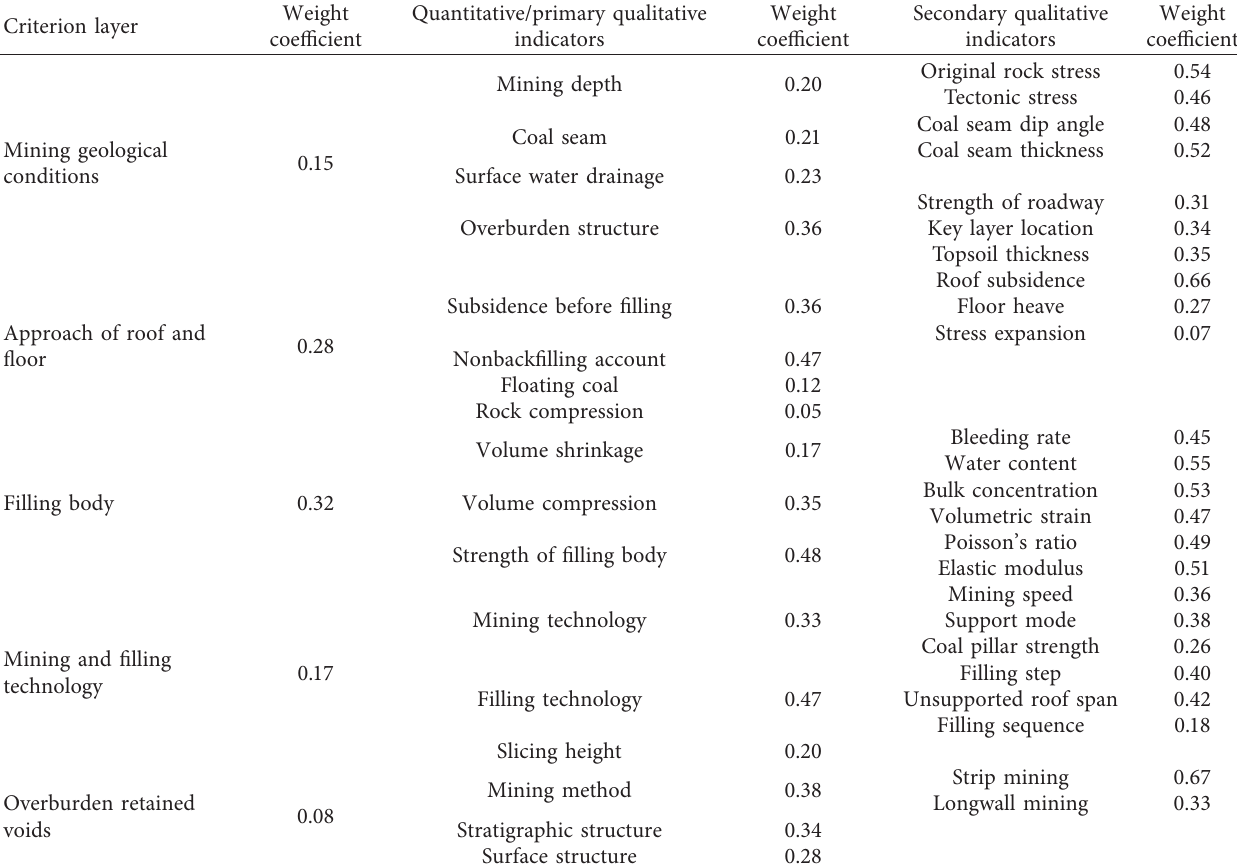
Table 6: Weight of evaluation